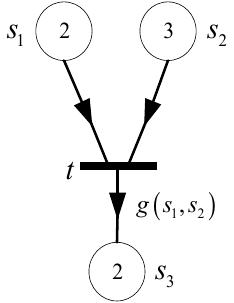
Figure 2. Reading arc and writing arc.